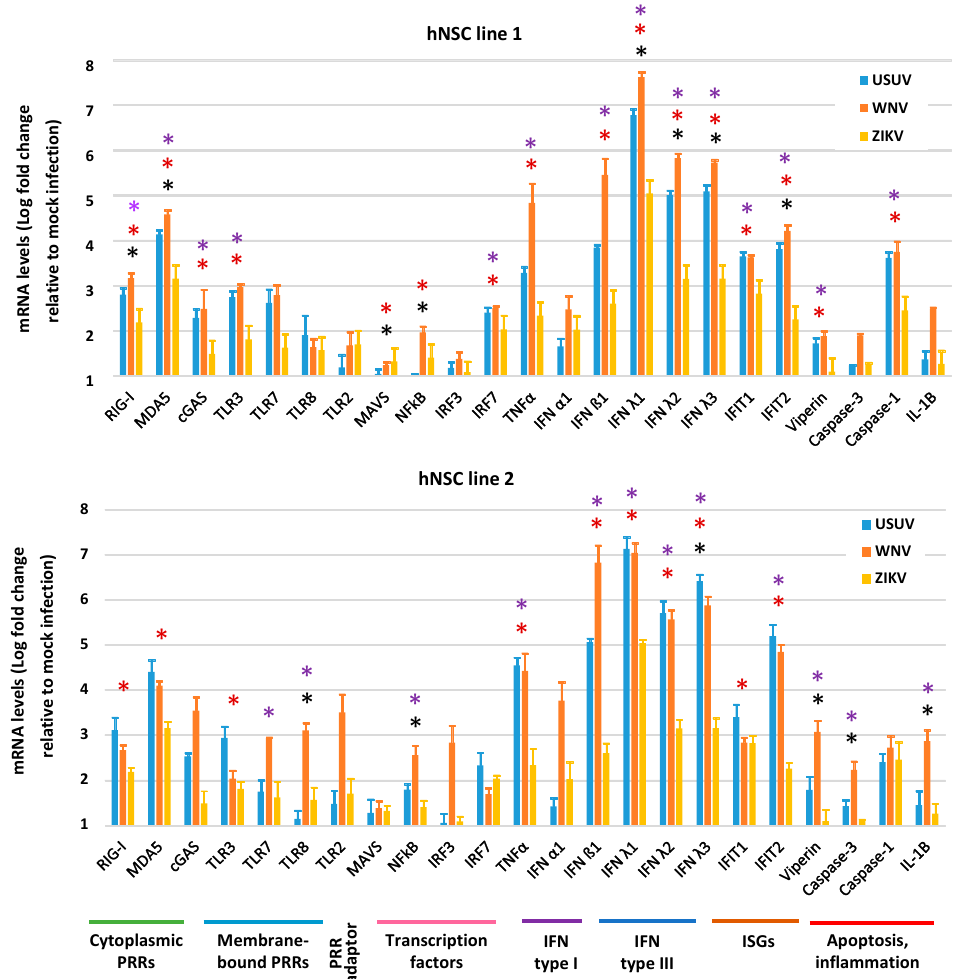
Figure 6. Antiviral innate immune response to WNV, USUV and ZIKV infection. qRT-PCR analysis of innate antiviral immune response gene expression in hNSC lines 1 and 2 at 4 dpi with WNV lineage 2, USUV Europe 1 and ZIKV Asian MOI 1. mRNA levels are represented as geometric mean ± SD of Log fold regulation (compared to mock control). Analyses were performed in triplicates and repeated in three independent experiments. * USUV vs. WNV; * USUV vs. ZIKV; * WNV vs. ZIKV; p < 0.05; Student’s t-test.